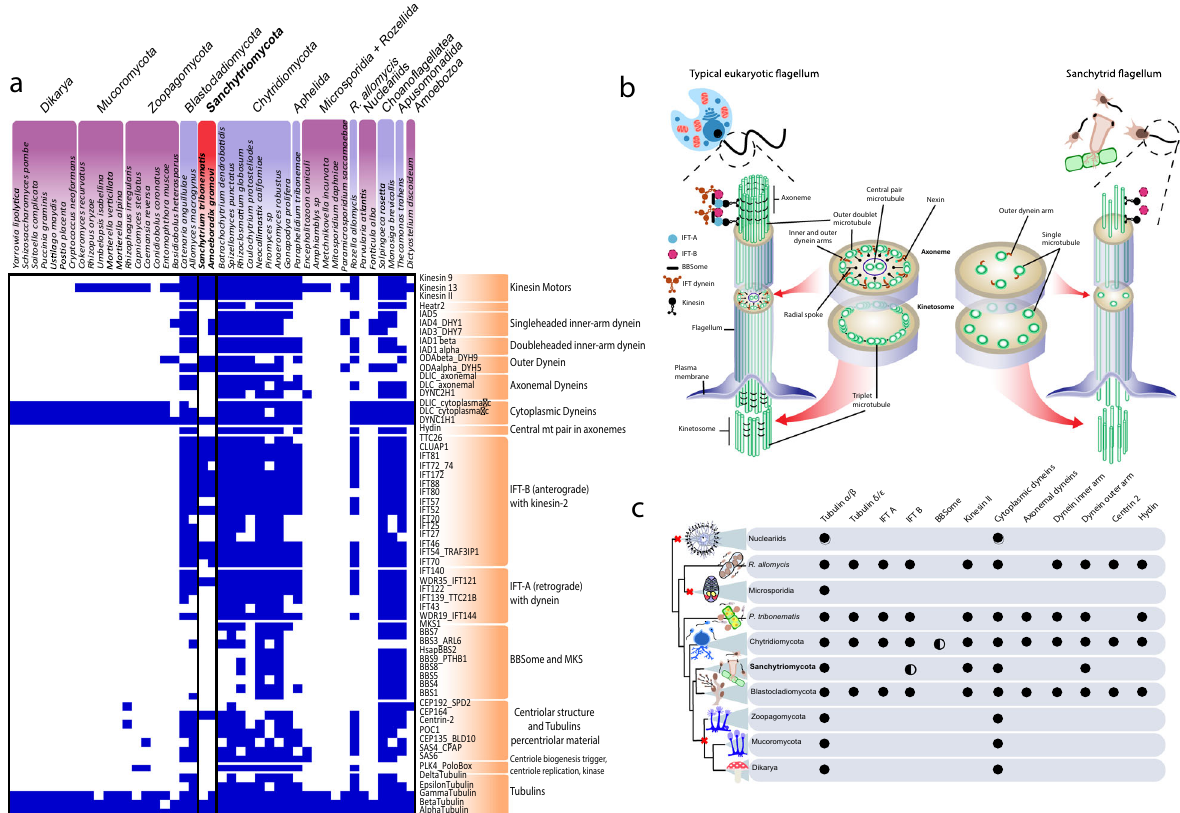
Fig. 4 Comparison of fl agellar protein distribution and structure in sanchytrids and other Holomycota. a Presence/absence heatmap of 61 fl agellum- speci fi c proteins in 43 eukaryotic fl agellated (purple; red: Sanchytriomycota) and non- fl agellated (pink) lineages. The right column lists microtubular genes and fl agellum-speci fi c genes (orange). b Illustration depicting the main structural elements present in a typical eukaryotic fl agellum (left) and a reduced sanchytrid fl agellum (right). Gene presence is depicted in blue and absence in white. c Representation of the evolutionary relationships of holomycotan lineages and their patterns of presence/absence of key molecular components of the fl agellar apparatus (full or half circles). Red crosses on branches indicate independent fl agellum